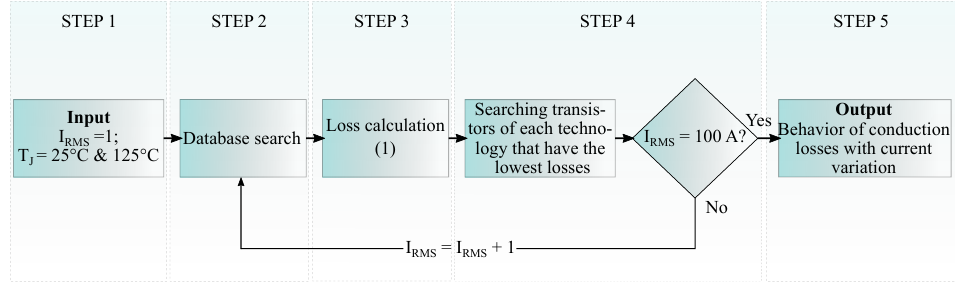
Figure 3. Flowchart: methodology for the selection of the MOSFET with lowest conduction losses for each